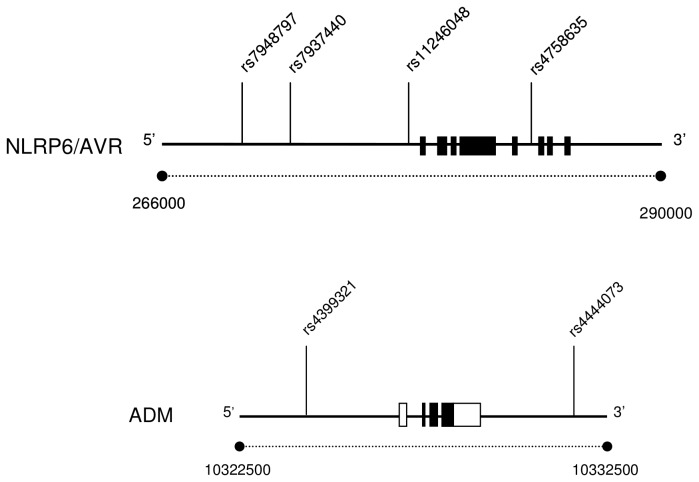
Structure of NLRP6/AVR and ADM genes and location of the SNPs analyzed.Exons (shown as boxes) 1–8 for NLRP6/AVR and exons 1–4 for ADM are shown. Gene untranslated (5′-untranslated and 3′-untranslated) regions are unfilled. Corresponding nucleotide positions for the NLRP6/AVR and ADM loci on chromosome 11 are indicated in bp. Locations of the SNPs genotyped are shown by vertical lines.